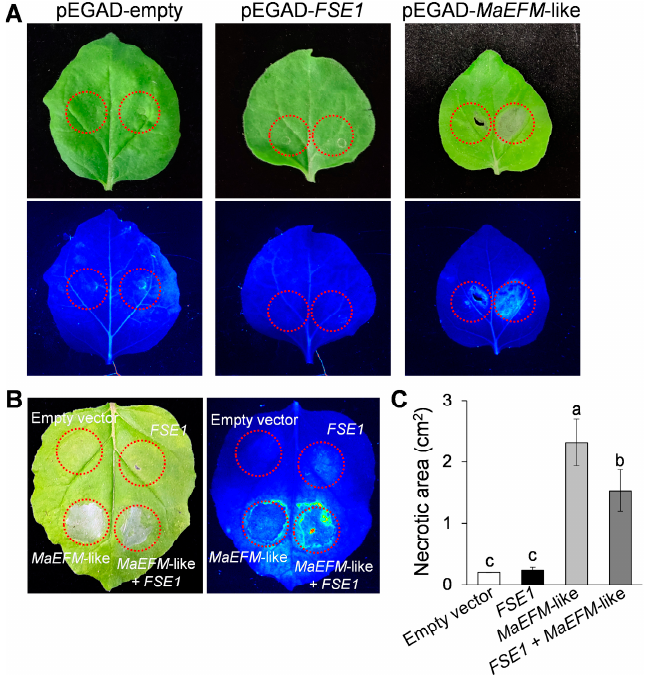
Figure 7. MaEFM-like induced cell death in tobacco leaves and FSE1 suppressed the cell death in- duced by MaEFM-like. ( A ) Leaves expressing empty vector, FSE1 , or MaEFM -like were photographed under normal light ( up ) and UV illumination ( bottom ). ( B ) FSE1 suppressed the cell death induced by MaEFM-like. ( C ) Statistical analysis of necrotic area in tobacco leaves. Data are shown as the means ± SD, and columns with different letters indicate significant difference ( p <